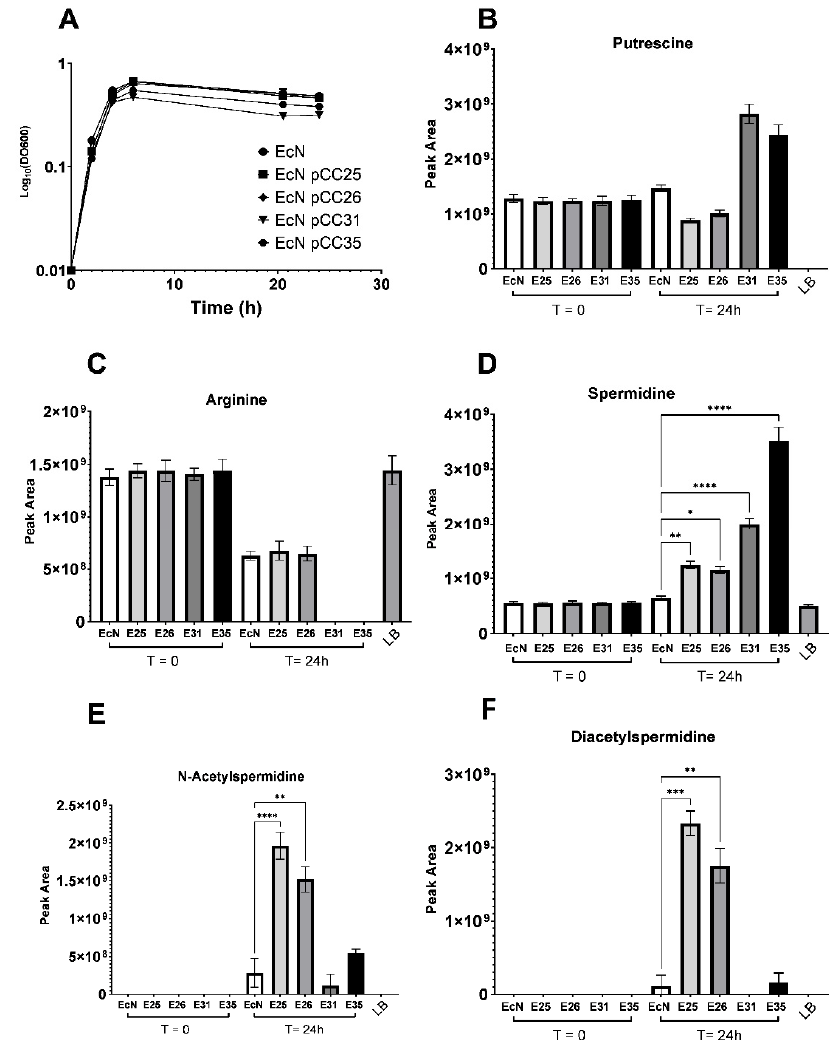
Figure 4. Targeted metabolomic analysis of EcN pCC25, pCC26, pCC31 and pCC35 compared with EcN WT in LB broth supplemented with 1mM of putrescine. ( A ) Growth curves of EcN, EcN pCC25, EcN pCC26, EcN pCC31 and EcN pCC35 in LB medium supplemented with 1mM of putrescine (n = 8). ( B – F ) Peak area of the metabolite involved in the metabolic pathways of spermidine (putrescine ( B ), arginine ( C ), spermidine ( D ), N8-acetylspermidine ( E ) and diacetylspermidine ( F ) used to estimate the amount of each metabolite in the culture supernatant of our strains at the beginning of the culture (0) or after 24 h (24) (n = 8). The individual data were obtained from independent cultures. All data shown represent the mean ± SD. Statistical significance was calculated using Kruskal–Wallis test and Benjamini, Krieger and Yekutieli Multiple comparisons. Statistical significance indicated as * p < 0.05, ** p < 0.01, *** p < 0.001, **** p < 0.0001.